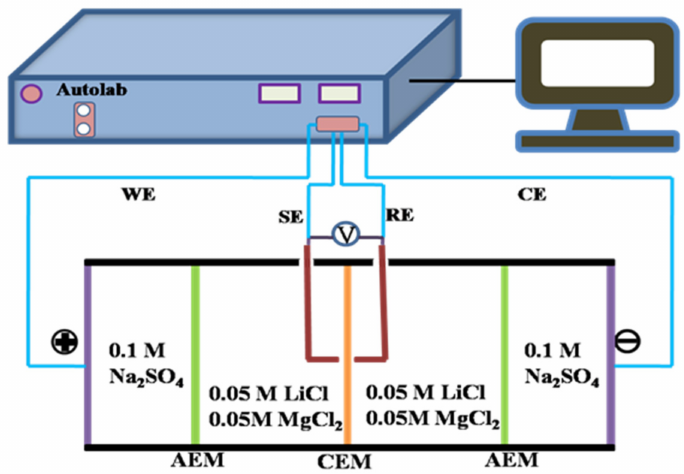
Figure 2. Schematic diagrams of the experimental setup for the measurement of EIS and polarization current–voltage